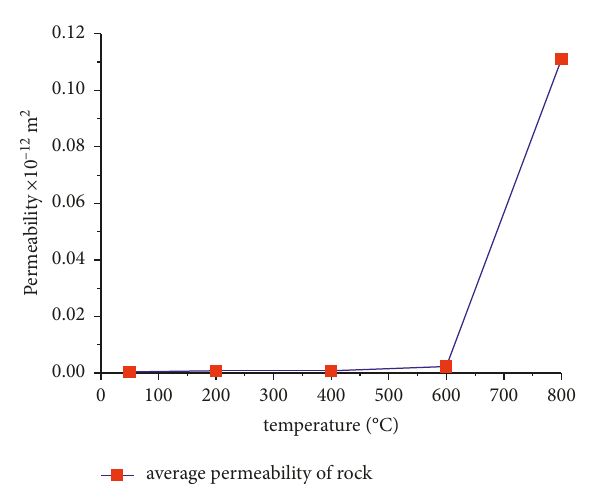
Figure 7: The influence of heating temperature on